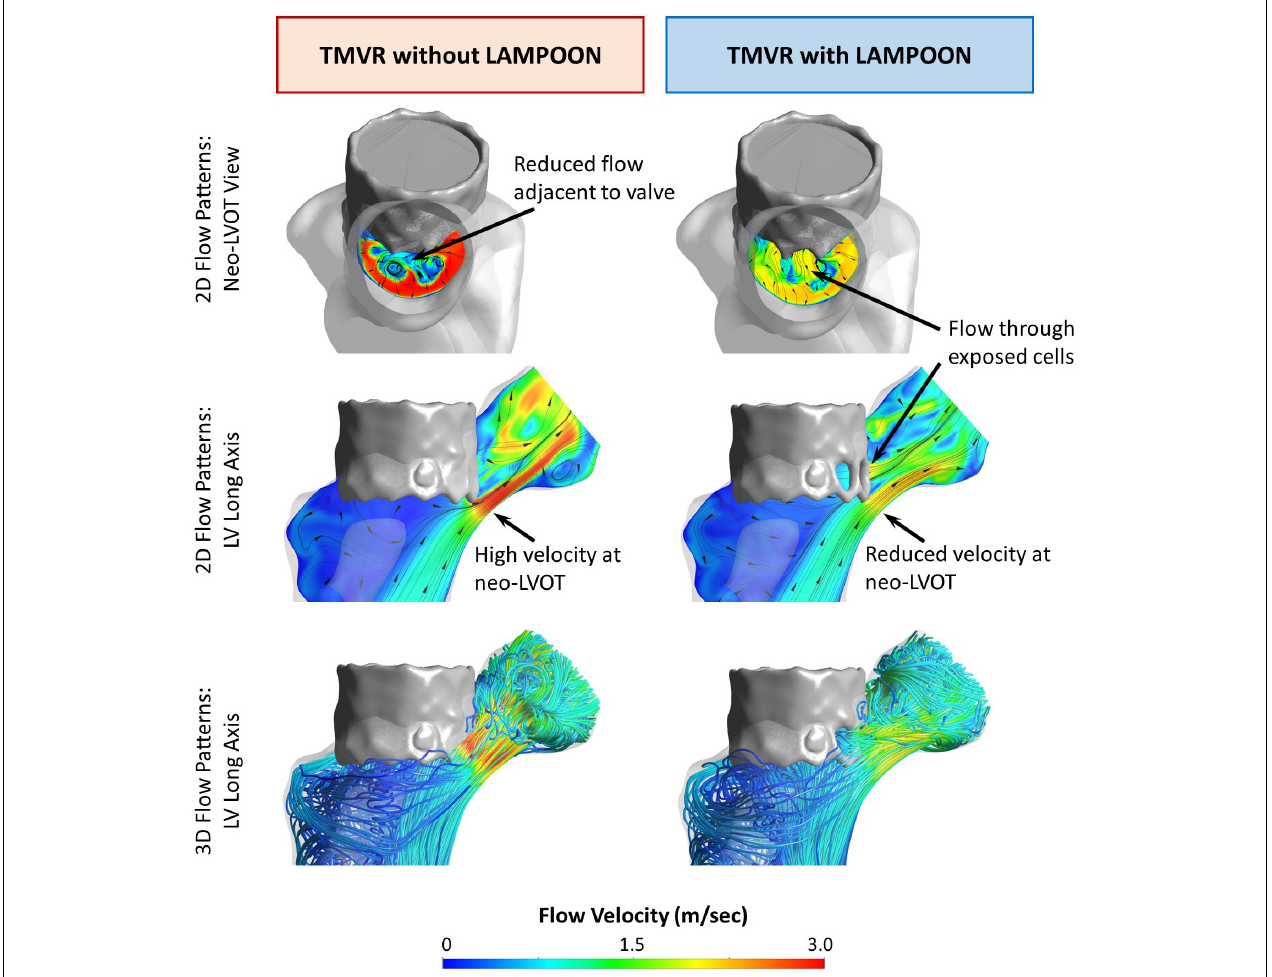
FIGURE 2 | Effect of LAMPOON on left ventricular flow patterns. Simulated flow patterns for a representative subject (Subject 5) are shown in color maps (red = highest velocity, blue = lowest velocity) with streamlines. The left column shows the flow simulation for the virtual control procedure (TMVR without LAMPOON). For this condition, all flow is directed through the narrowed residual LVOT (neo-LVOT), resulting in a narrowed and high-velocity outflow jet. Additionally, there is a region of reduced flow in the immediate vicinity of the valve (upper left image). The right column shows the flow simulation for the actual performed procedure (TMVR with LAMPOON). For this condition, additional flow occurs through exposed cells of the transcatheter valve due to LAMPOON. Following LAMPOON, the velocity of flow through the neo-LVOT is reduced, and there is improved flow in the immediate vicinity of the valve (upper right image). Ao, aorta; LV, left ventricle; neo-LVOT, neo-left ventricular outflow tract; THV, transcatheter heart valve.